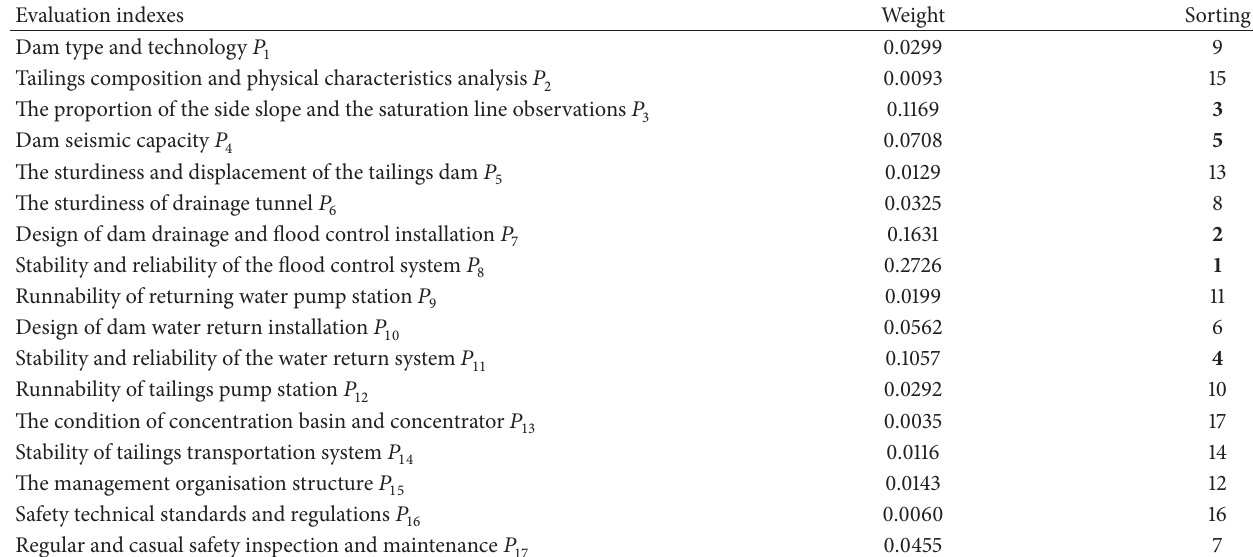
Table 1: Total sorting for the hierarchy